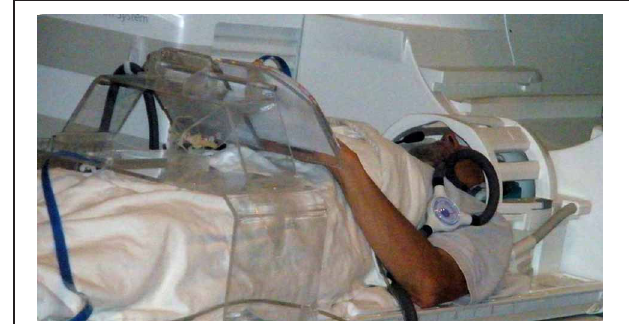
FIGURE 4 | A subject on the scanner bed operating our novel multimodal MRI-compatible drawing device. The plexiglass gantry supports a drawing tablet while a fiber-optic drawing stylus captures and records the drawing movements with high precision. The motion capture information synchronized with the fMRI allows the effect of behavioral events to be